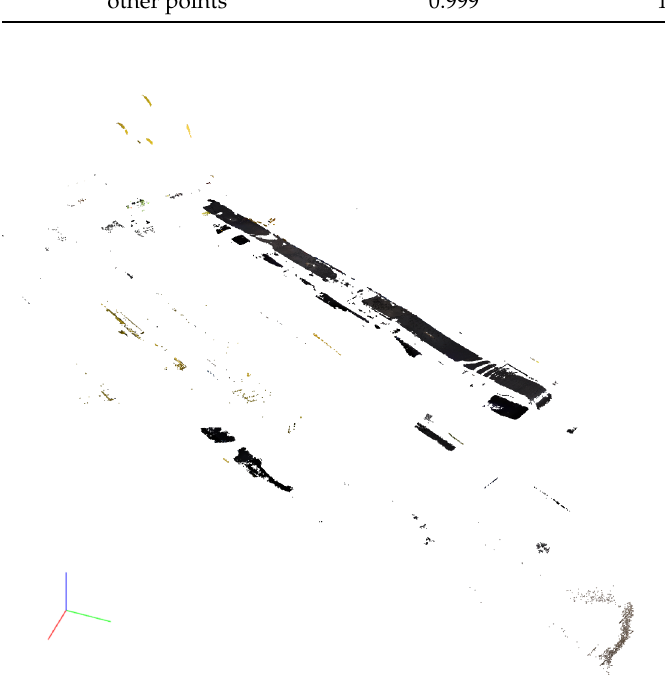
Figure 11. Preliminary belt detection with an XGBoost Classifier.